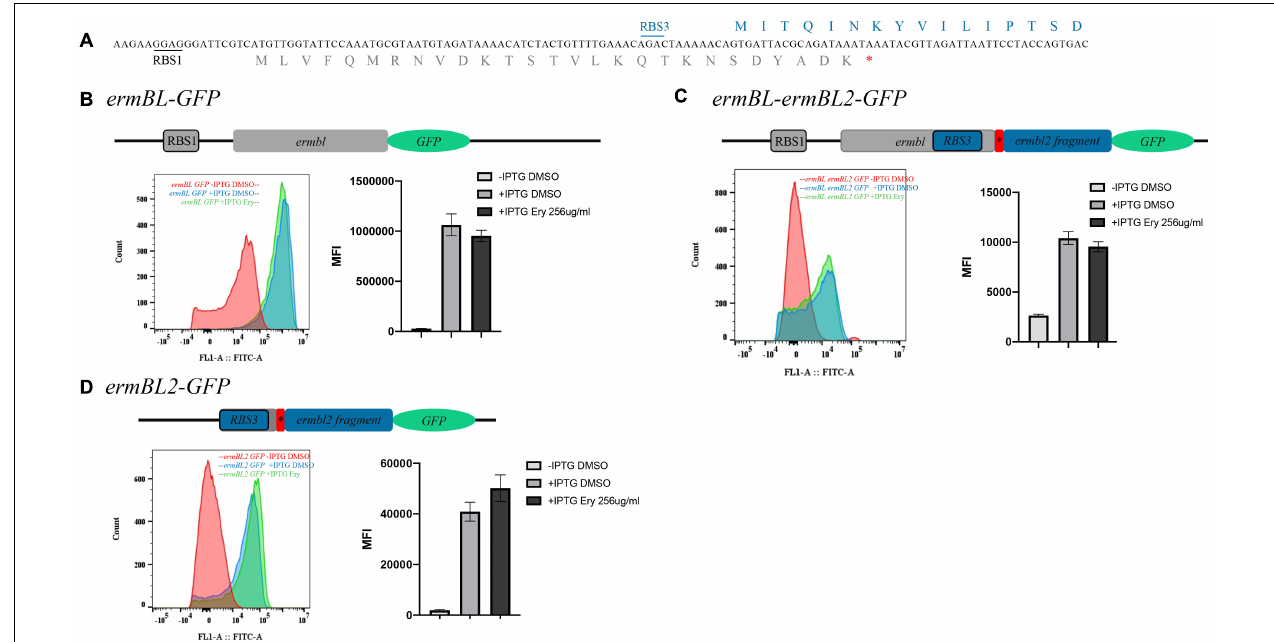
FIGURE 6 | Erythromycin has no effect on leader peptide expression. (A) The detailed sequence of ermBL and the new leader peptide named ermBL2 . (B) The structure of the ermBL-GFP translational fusion. The fusion contains the RBS1 sequence and full length of ermBL without the TAA stop codon. Flow cytometry of GFP intensity is shown. (C) The structure of the ermBL-ermBL2-GFP translational fusion. The fusion contains the full length of ermBL and ermBL2 without the stop codon of ermBL2. Flow cytometry of GFP intensity is shown. (D) The structure of the ermBL2-GFP translational fusion. The fusion contains the RBS3 sequence and full length of ermBL2 without the TAA stop codon. Flow cytometry of GFP intensity is shown. Data are mean ± SEM from three independent experiments (unpaired two-tailed Student’s t -test). Figure 7 | N-terminal region of ermBL2 is necessary for ermB induction by erythromycin. (A) Amino acid sequences of erm BL2 peptide (WT) and its alanine-scanning mutations. (B) β -Galactosidase activity and agar diffusion assays of the degree of Ery induction in vivo following Ala mutation of ermBL2 amino acid sequences. (C) β -Galactosidase activity and agar diffusion assays of the degree of Ery induction in vivo following introduction of premature termination codons in ermBL2 . Data are mean ± SEM from three independent experiments (unpaired two-tailed Student’s t -test).